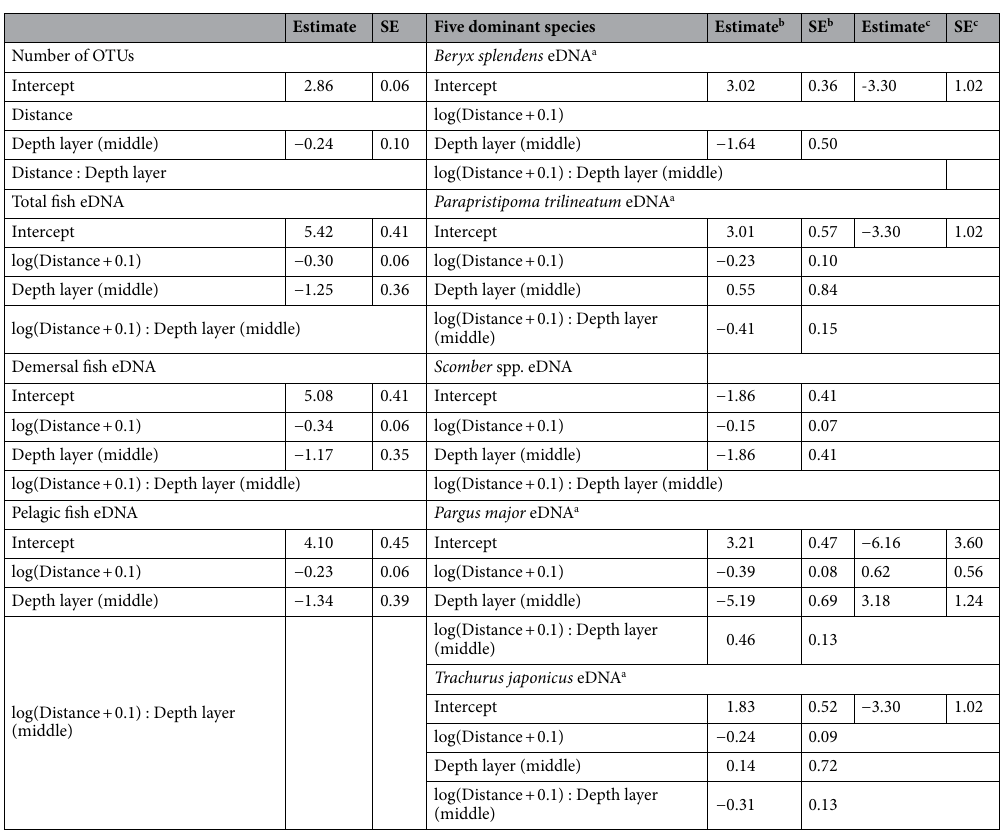
Table 1. Parameters of distance from ARs, sampled depth layer, and their interaction term for number of OTUs or each response variable of eDNA quantities estimated from a BIC minimum model based on generalized liner modelling. a Gamma hurdle model was used. b An estimate and error of Gamma component when using Gamma or Gamma hurdle model. c An estimate and error of binomial component when using Gamma hurdle